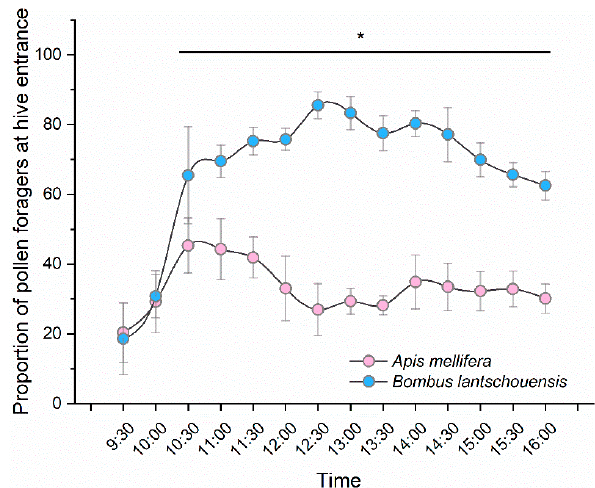
Figure 4. Daily pattern of pollen-collecting activity of Apis mellifera and Bombus lantschouensis in the peach solar greenhouse. The behaviour data were obtained from eleven days and a total of 154 behaviour records were obtained for both the honeybee colony and bumblebee colony. Data are presented as the mean ± S.D. The “*” indicates significant difference between the proportion of pollen foragers of honeybee and bumblebee. The number of pollen foragers at the hive entrance divided by the number of total returning foragers was calculated as the proportion of pollen foragers. Independent-sample T tests were used to compare the differences in pollen forager proportions between honeybees and bumblebees at each time point (Table S1).